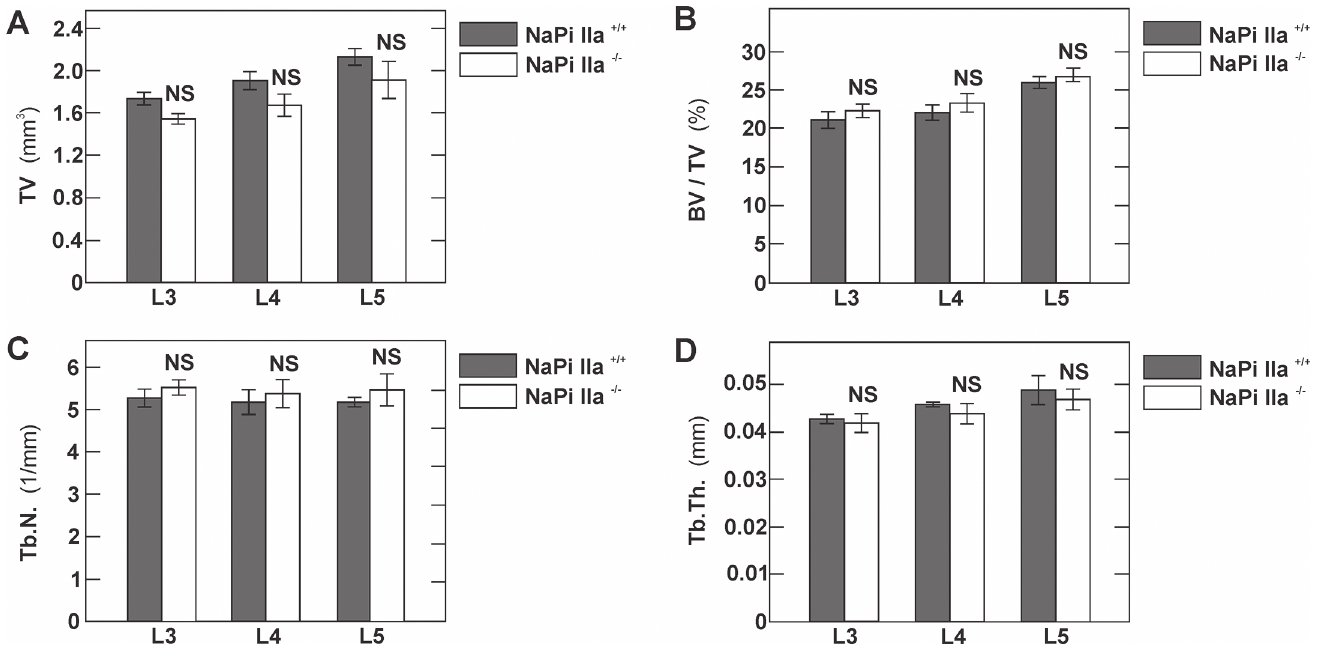
Fig 6. Structural bone parameters of NaPi-IIa KO mice. Lumbar vertebrae (# 3, 4 and 5) of 12 weeks old NaPi-IIa WT and KO mice were isolated and analyzed by μ CT. Histograms representing structural parameters of the lumbar vertebrae: Total volume, bone volume fraction (BV/TV), trabecular number (Tb.N.) and trabecular thickness (Tb.Th.). Data are shown as mean ± SD, n = 4 mice in each group. NS, not